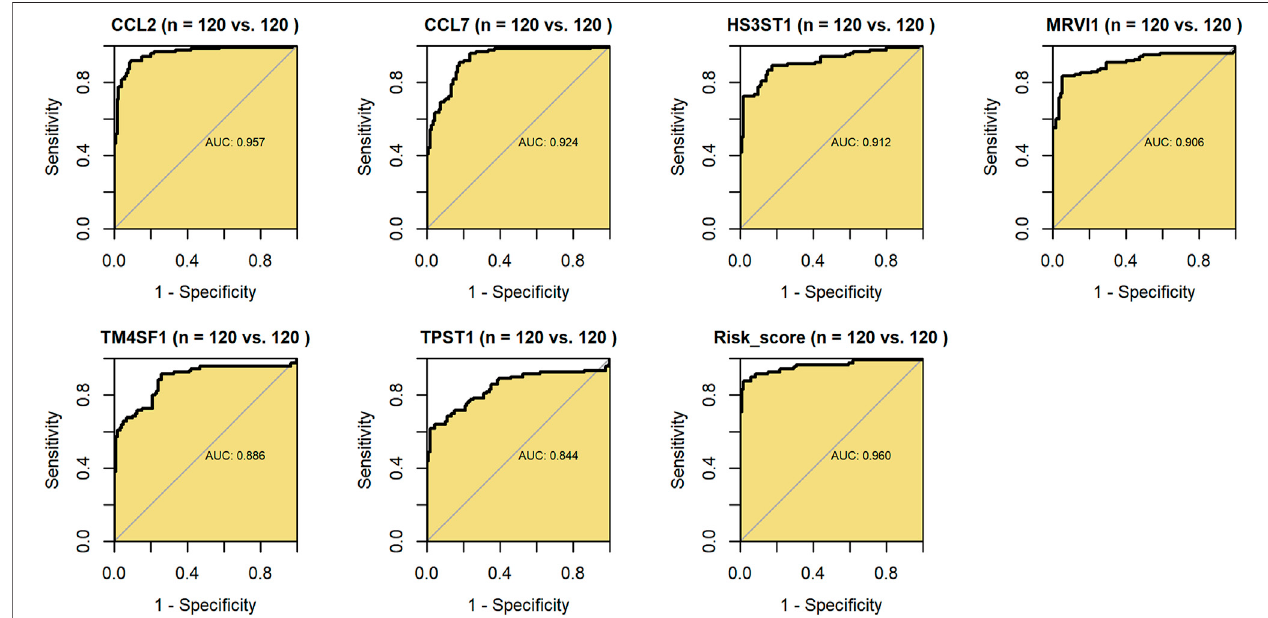
FIGURE 6 | The accuracy of m7GPS and its constitutive genes in distinguishing IPF bronchoalveolar lavage and healthy lung bronchoalveolar lavage. AUC, area under the curve. Synthetic minority oversampling technique data were used in this fi gure.